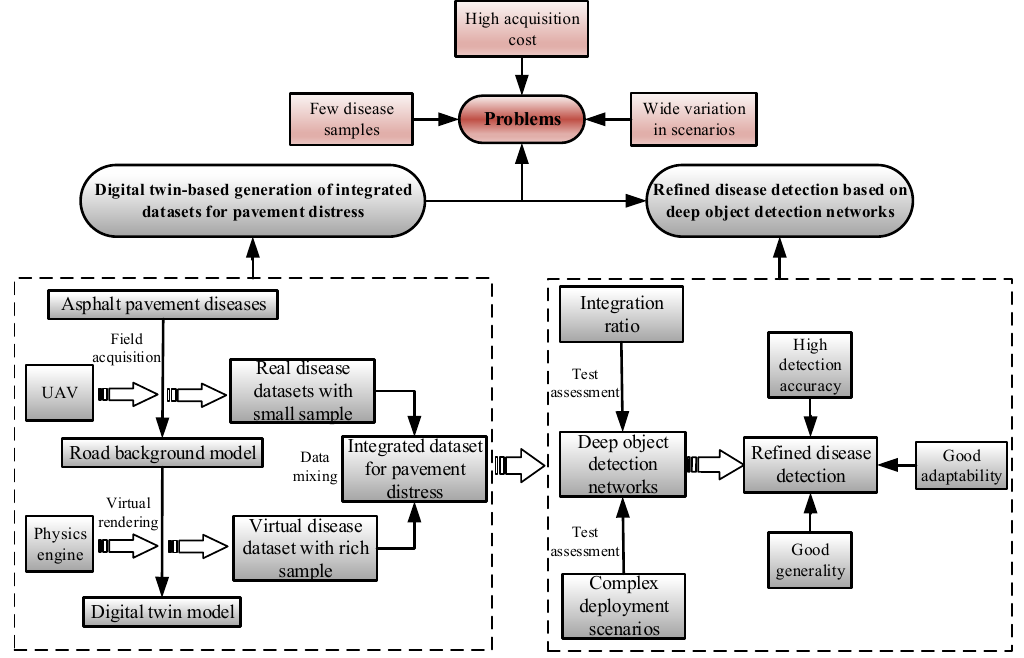
Figure 1. Total architecture of refined detection algorithm for asphalt pavement distress based on integrated data using digital twin.